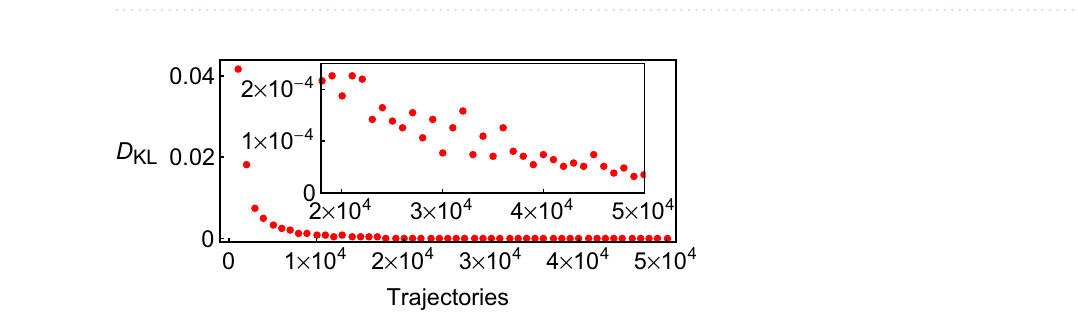
Figure 11. Kullback–Leibler divergence comparison at every 2000 trajectories/cycles. A good convergence is obtained for the number of trajectories analyzed in this Section.